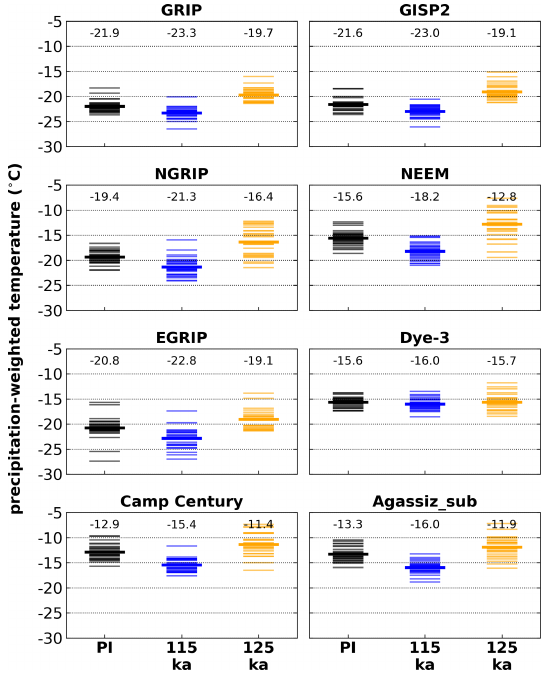
Figure A1. Annual mean precipitation-weighted temperature at Greenland ice core locations simulated by the MAR climate model for three time slices. Individual model years (thin lines) and the mean (bold lines, numerical values on top of columns) are shown.